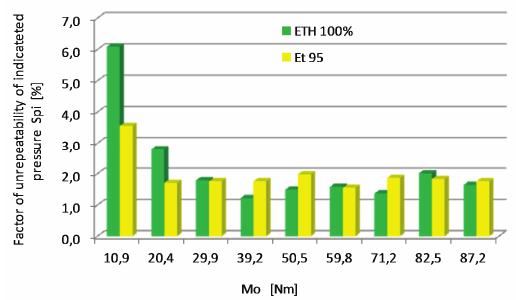
Fig. 9. Comparison variability factor of mean indicated pressure in the Fiat 1100 MPI engine run on Et 95 gasoline and Eth 100% ethyl alcohol